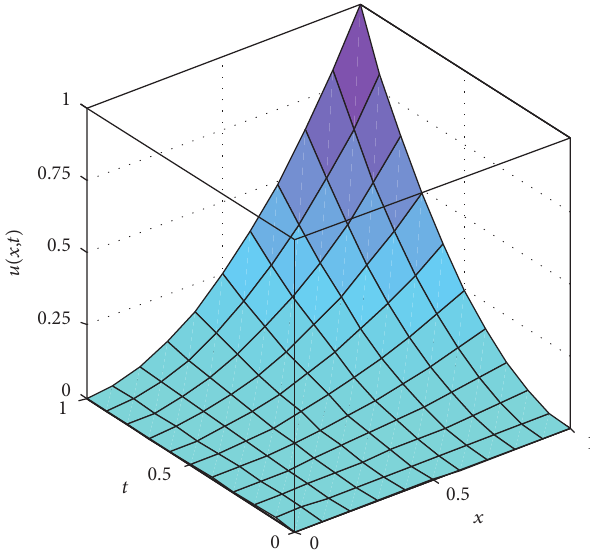
Figure 1: Numerical solution with 𝑚 = 6 for Example 1.